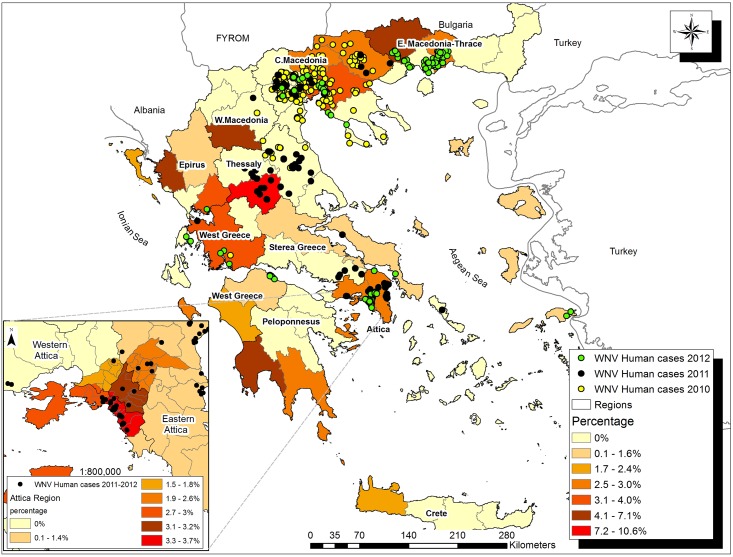
Area map of Greece according to WNV IgG seroprevalence levels (level NUTS 3) together with the geographical distribution of recorded human cases recorded during 2010–2012.